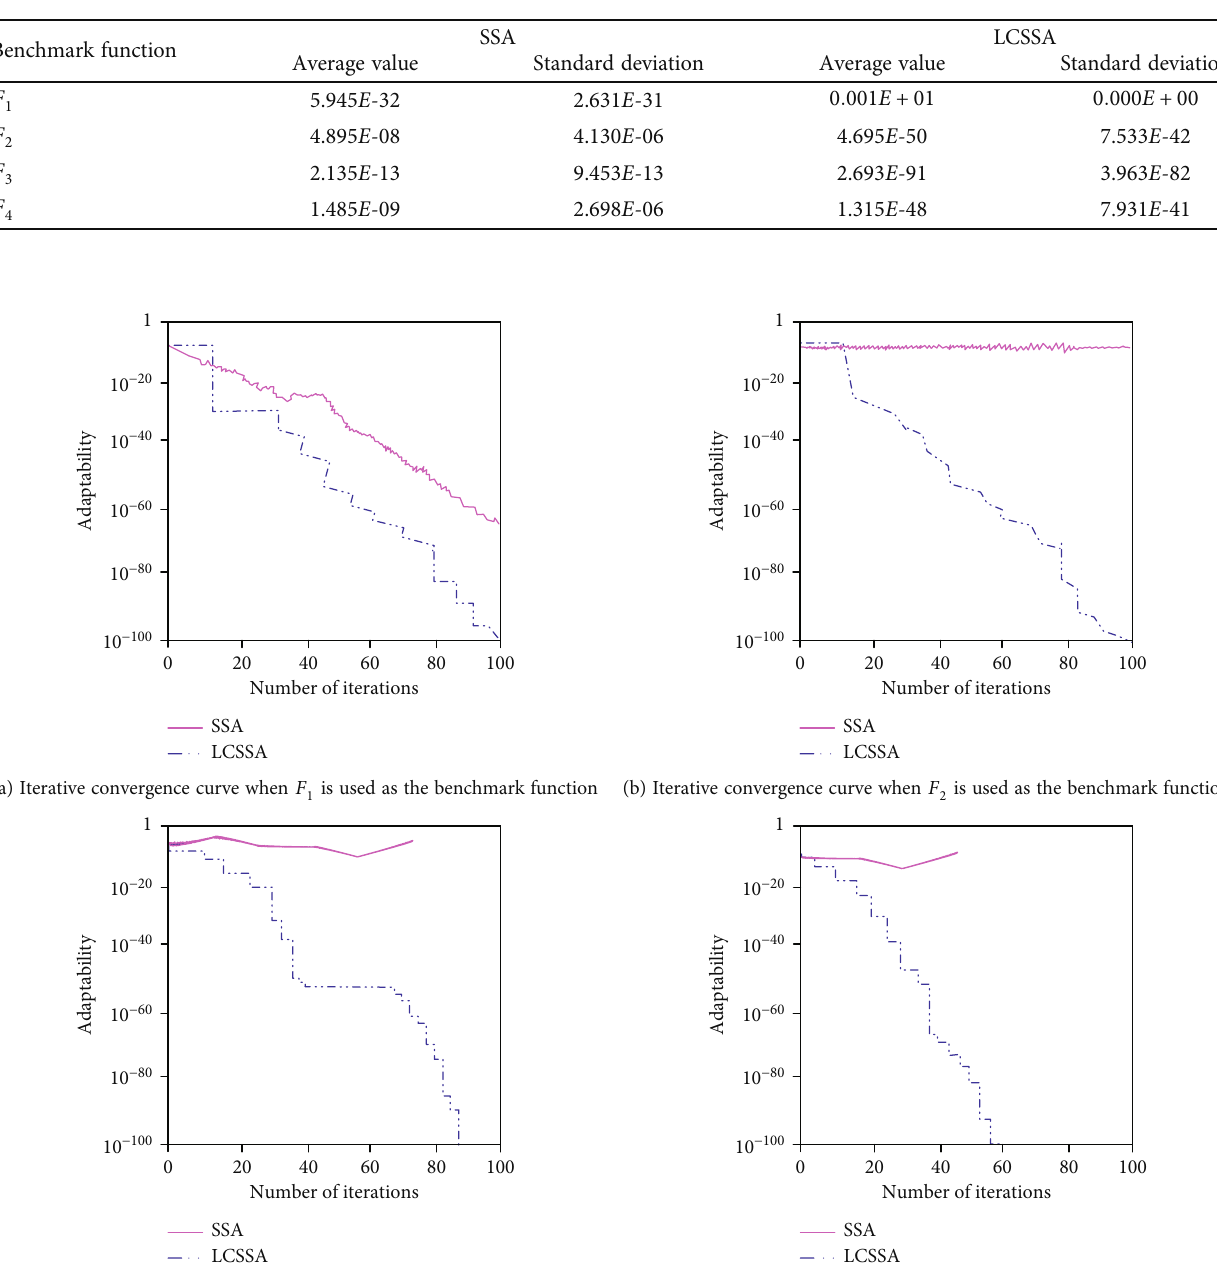
(d) Iterative convergence curve when F 4 is used as the benchmark function Figure 6: Iterative curves of SSA and LCSSA under 4 benchmark functions.